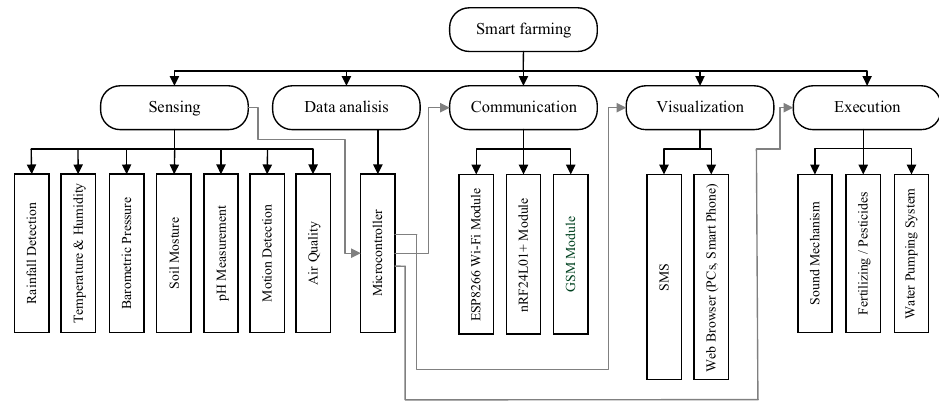
Figure 2. The structure of an intelligent automation system for an agricultural enterprise.